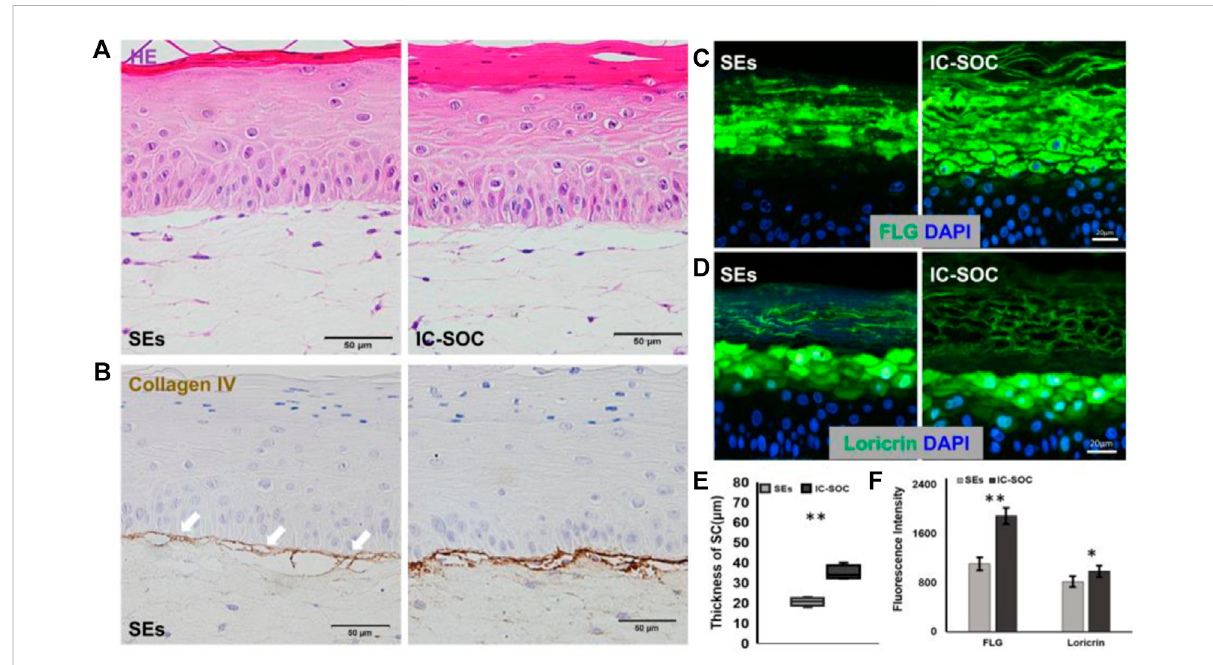
FIGURE 4 Impact of micro fl uidics on basement membrane development. (A) H&E cross section of the skin in the SEs and IC-SoC. (B) Basement membrane as revealed by collagen type IV expression, which is indicated by white arrows. Scale bars: 50 μ m. (C,D) Expression of differentiation markersFLG: fi laggrin (C) andloricrin (D) inepidermisoftheSEsandIC-SoC. (E) StatisticalanalysisofSCthicknessesintheskinoftheSEsandIC-SoC. (F) Statistical analysis of expression of FLG and loricrin ( n = 5 per condition, p ** < 0.01; p *** <